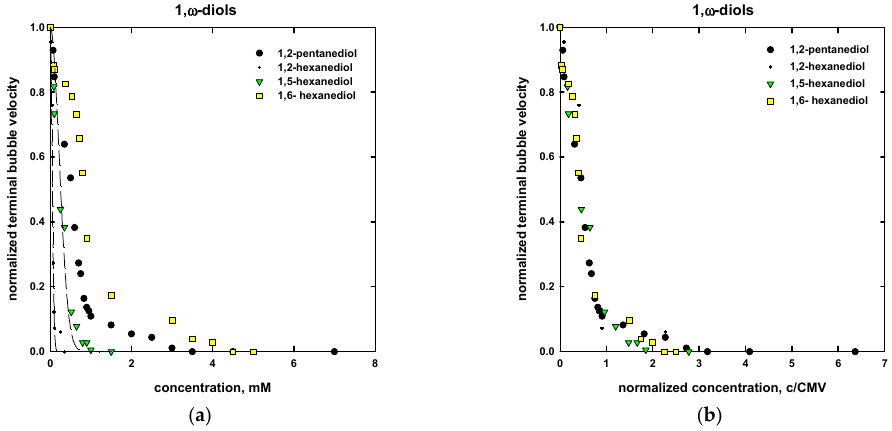
Figure 7. Influence of 1, ω -diols concentration expressed in mM ( a ) and normalized surfactant concentration ( c /CMV) ( b ) on the normalized terminal bubble velocity.